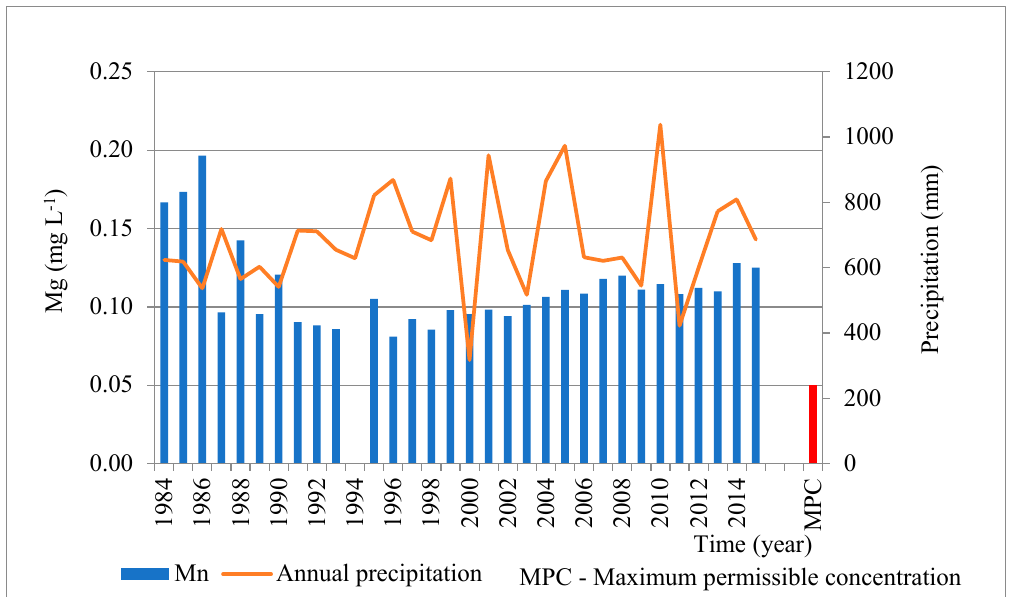
Figure 14. Manganese concentrations in groundwater sampled at the Vinogradi Pumping Station, Osijek, Croatia in the period 1984–2015.